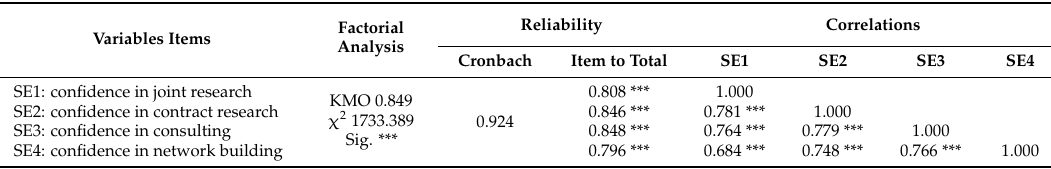
Table 3. Reliability and validity analysis of